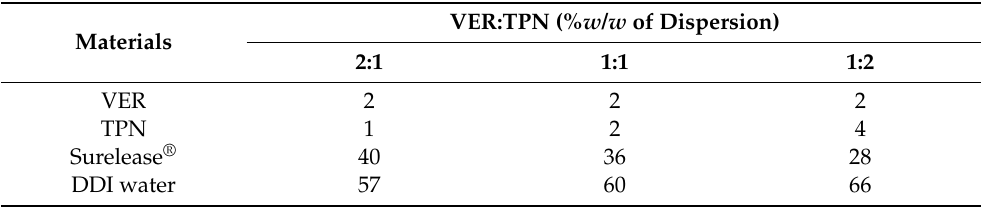
Table 2. Composition of VER-TPN-EC dispersion for making matrix